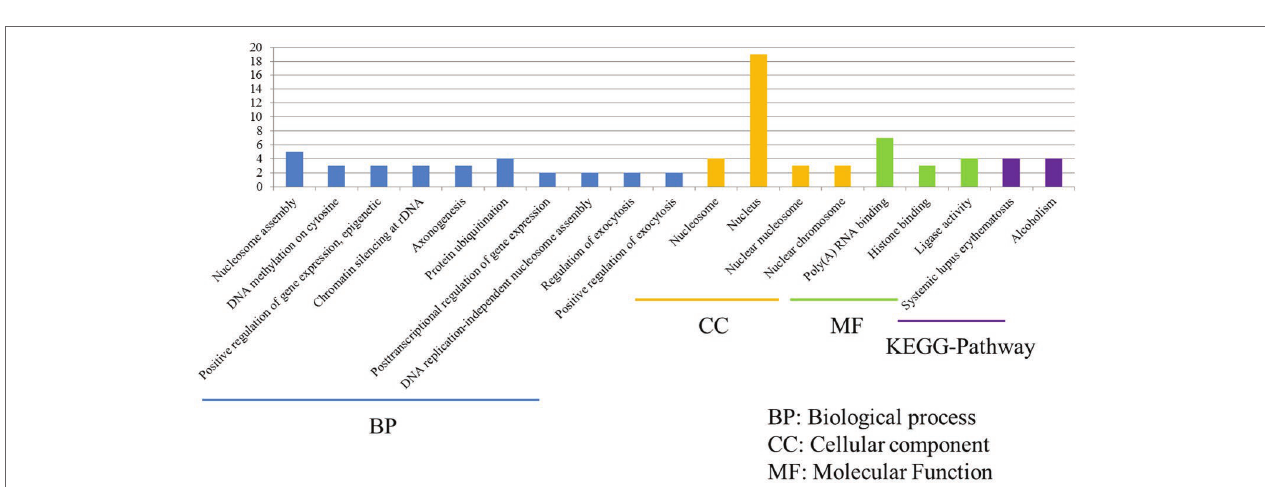
FIGURE 6 | Functional annotations and bioinformatic characterization of common DEGs in P815 cells with IAV infection. The GO biological process terms, GO cellular component terms and GO molecular function terms of common DEGs in P815 cells with IAV infection. Blue bar chart represented biological classification of the IAV - regulated unique DEGs in P815 cells. Orange bar chart represented cellular classification of the IAV-regulated unique DEGs in P815 cells. Green bar chart represented molecular classification of the IAV-regulated unique DEGs in P815 cells.